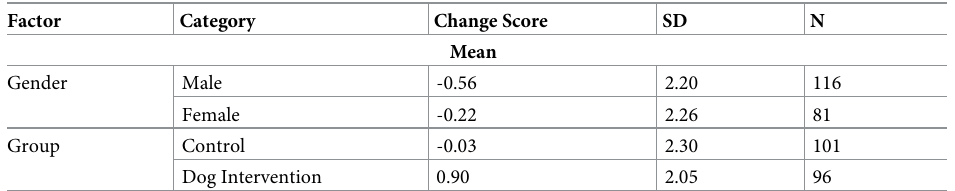
Table 4. Descriptive statistics for pain.